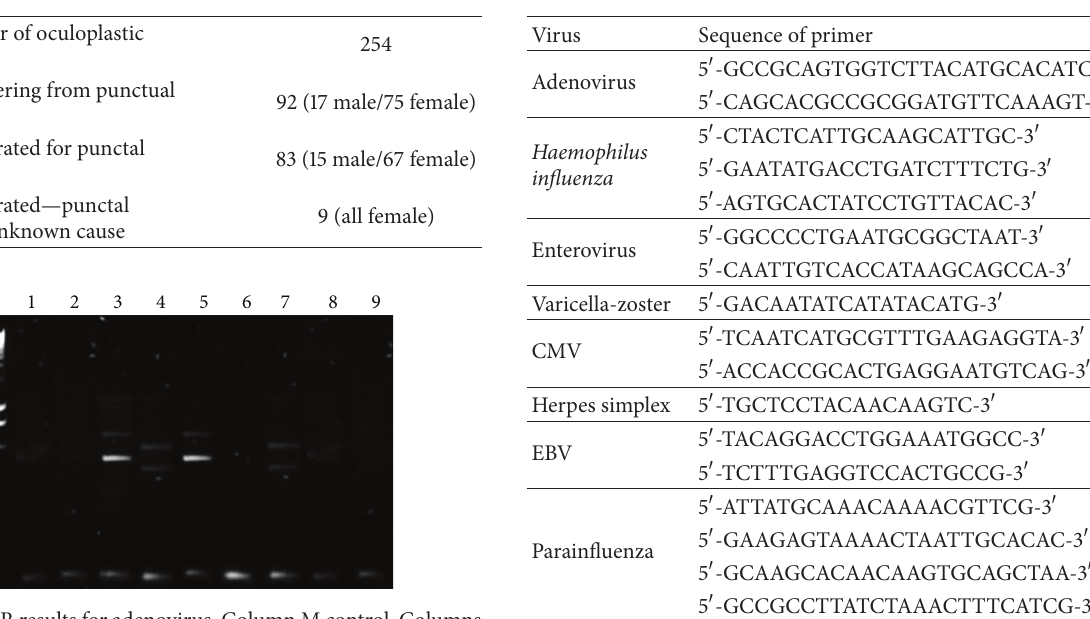
Table 3: Demographic data.